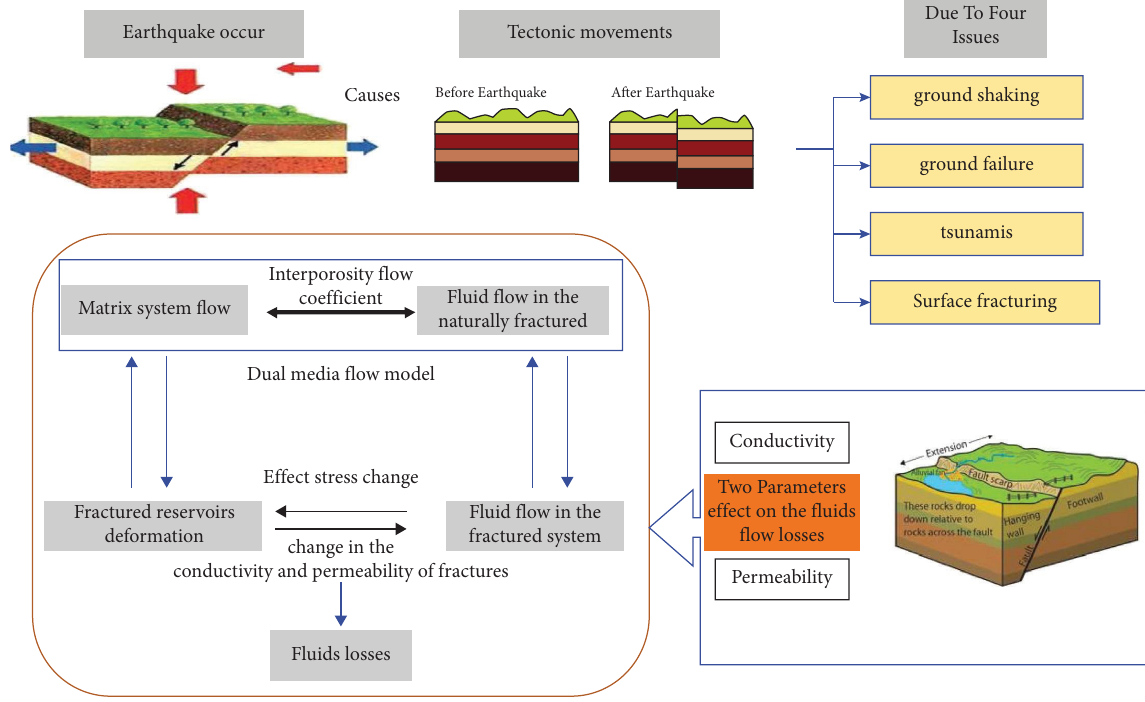
Figure 1: Fluid fow losses in the naturally fractured